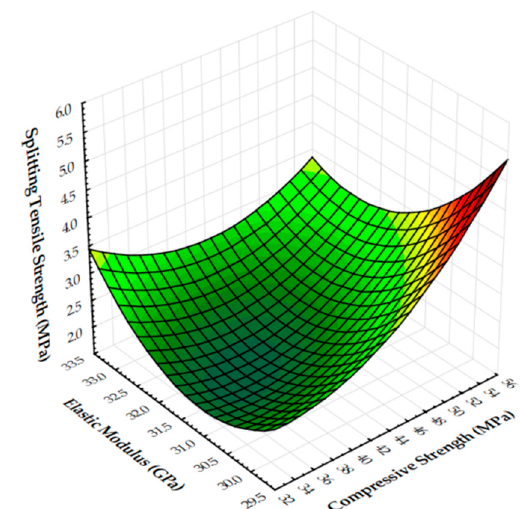
Figure 11. Three-dimensional surface plot of flexural strength (MPa) against compressive strength (MPa) and elastic modulus (GPa).